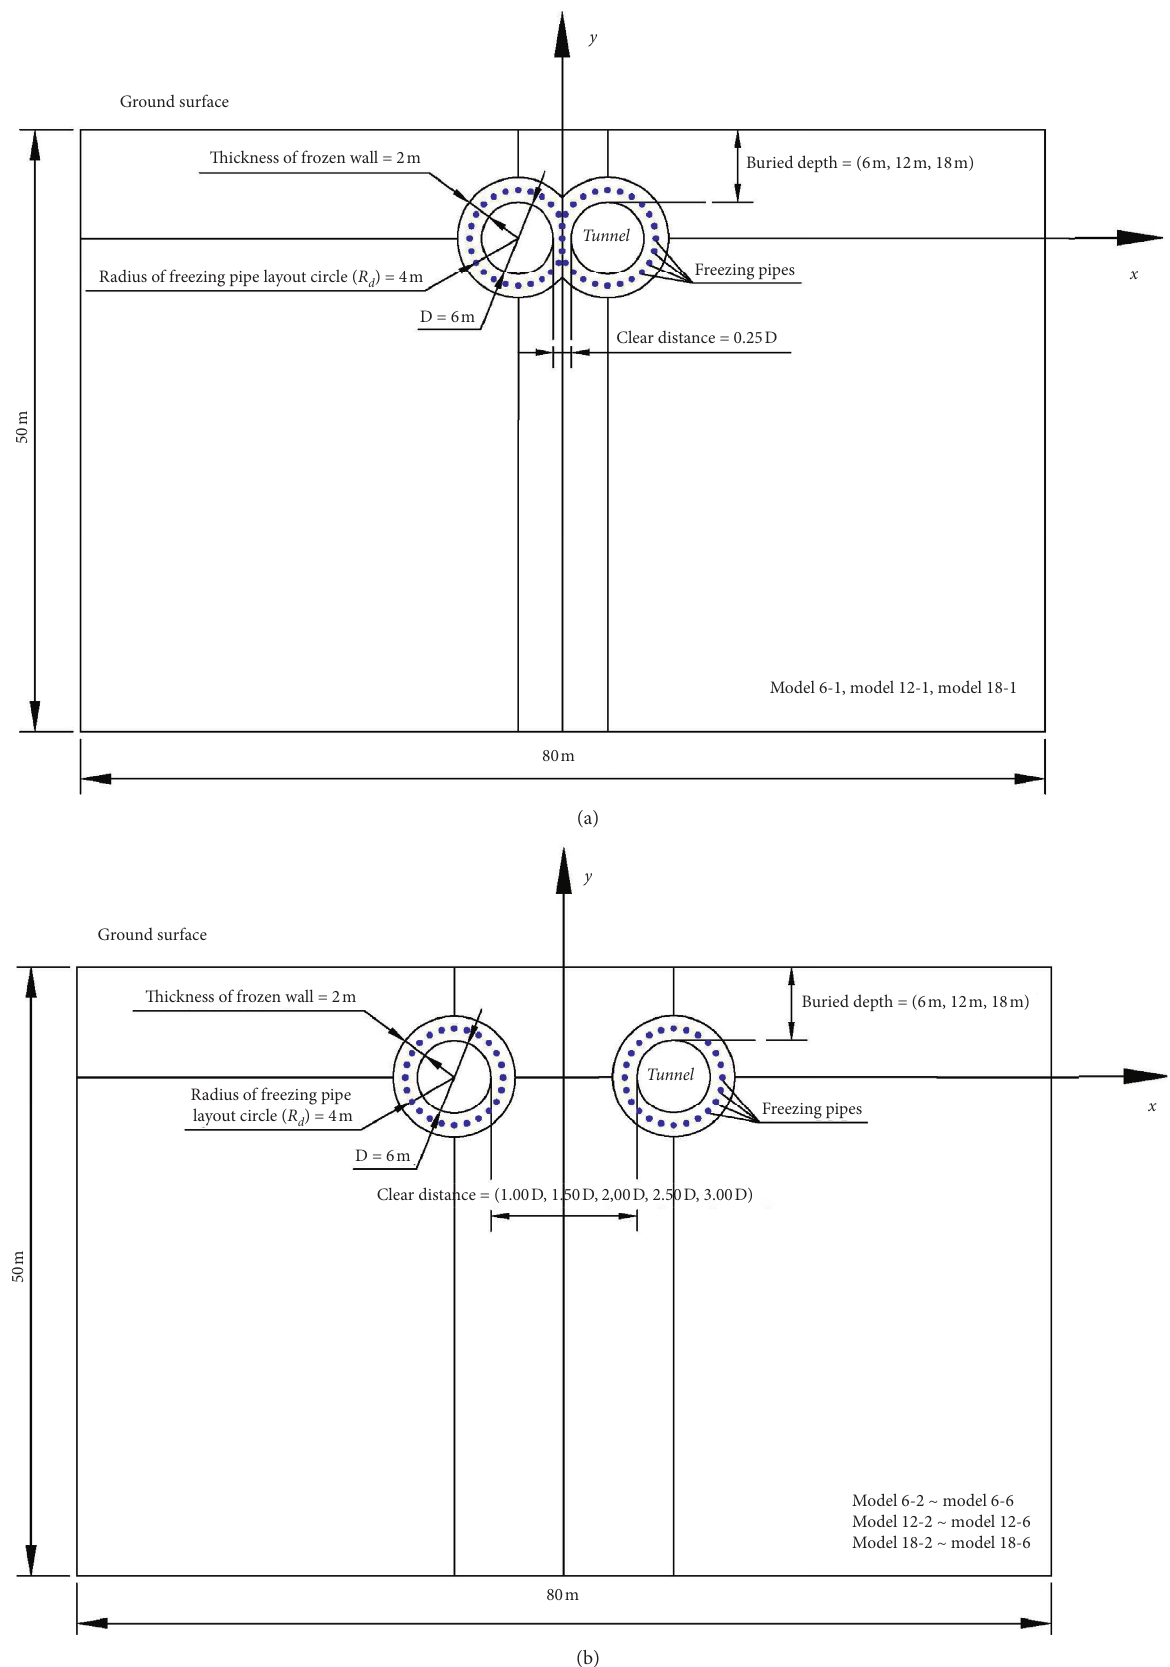
Figure 3: Two-dimensional geometric calculation